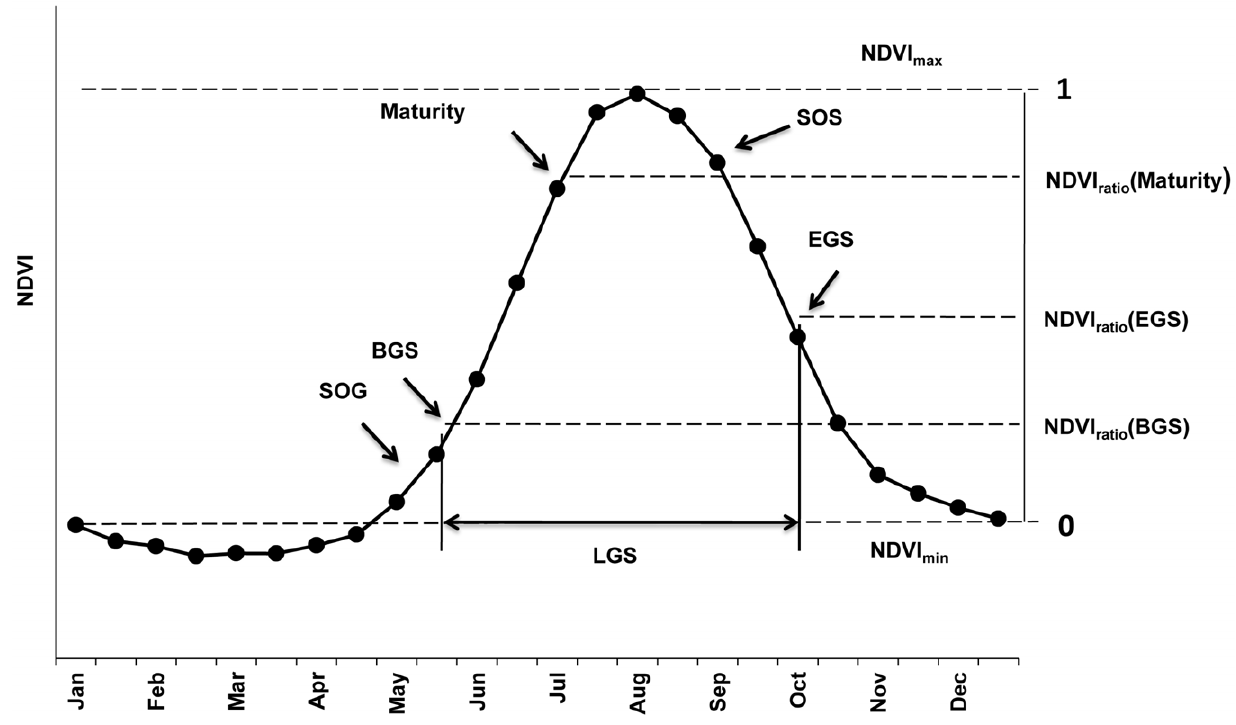
Figure 2. Illustration of the NDVI ratio method for determining the timing of vegetation stages. All NDVI values are expressed relative to the range between minimum (substituted here by the mean of all positive NDVI values during February and March) and maximum NDVI of the season. Rules for determining the timing and beginning of the Start of Green-up (SOG), the Beginning of the Growing Season (BGS), Maturity, Start of Senescence (SOS) and the End of the Growing Season (EGS) are given in the